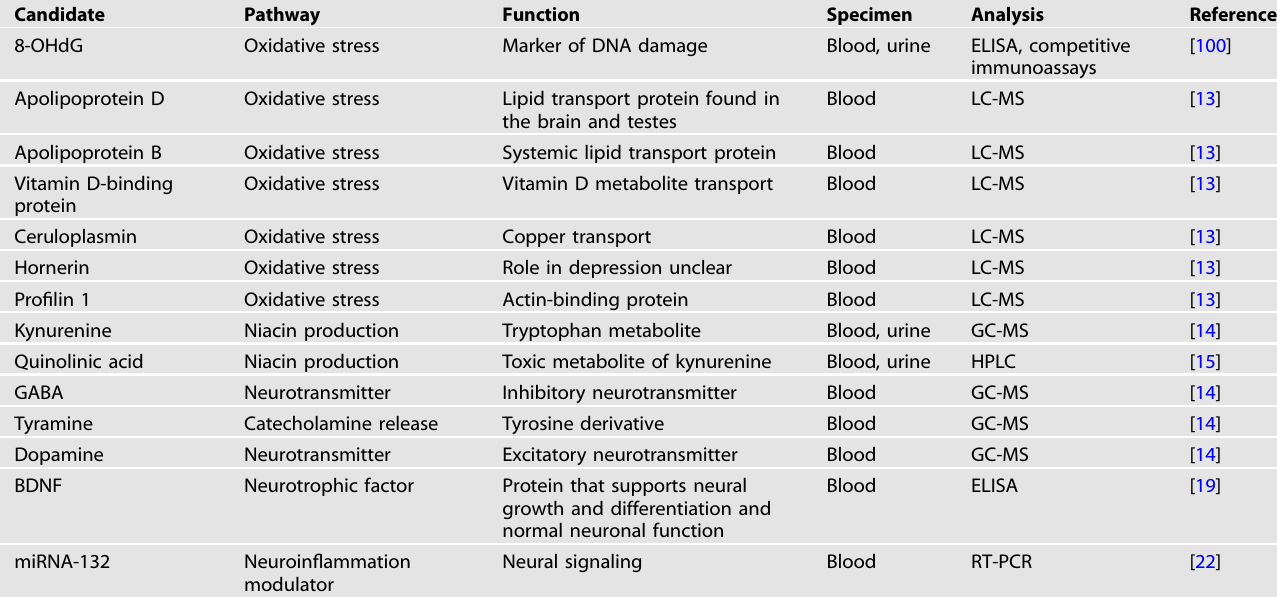
Table 1. Potential candidate MDD